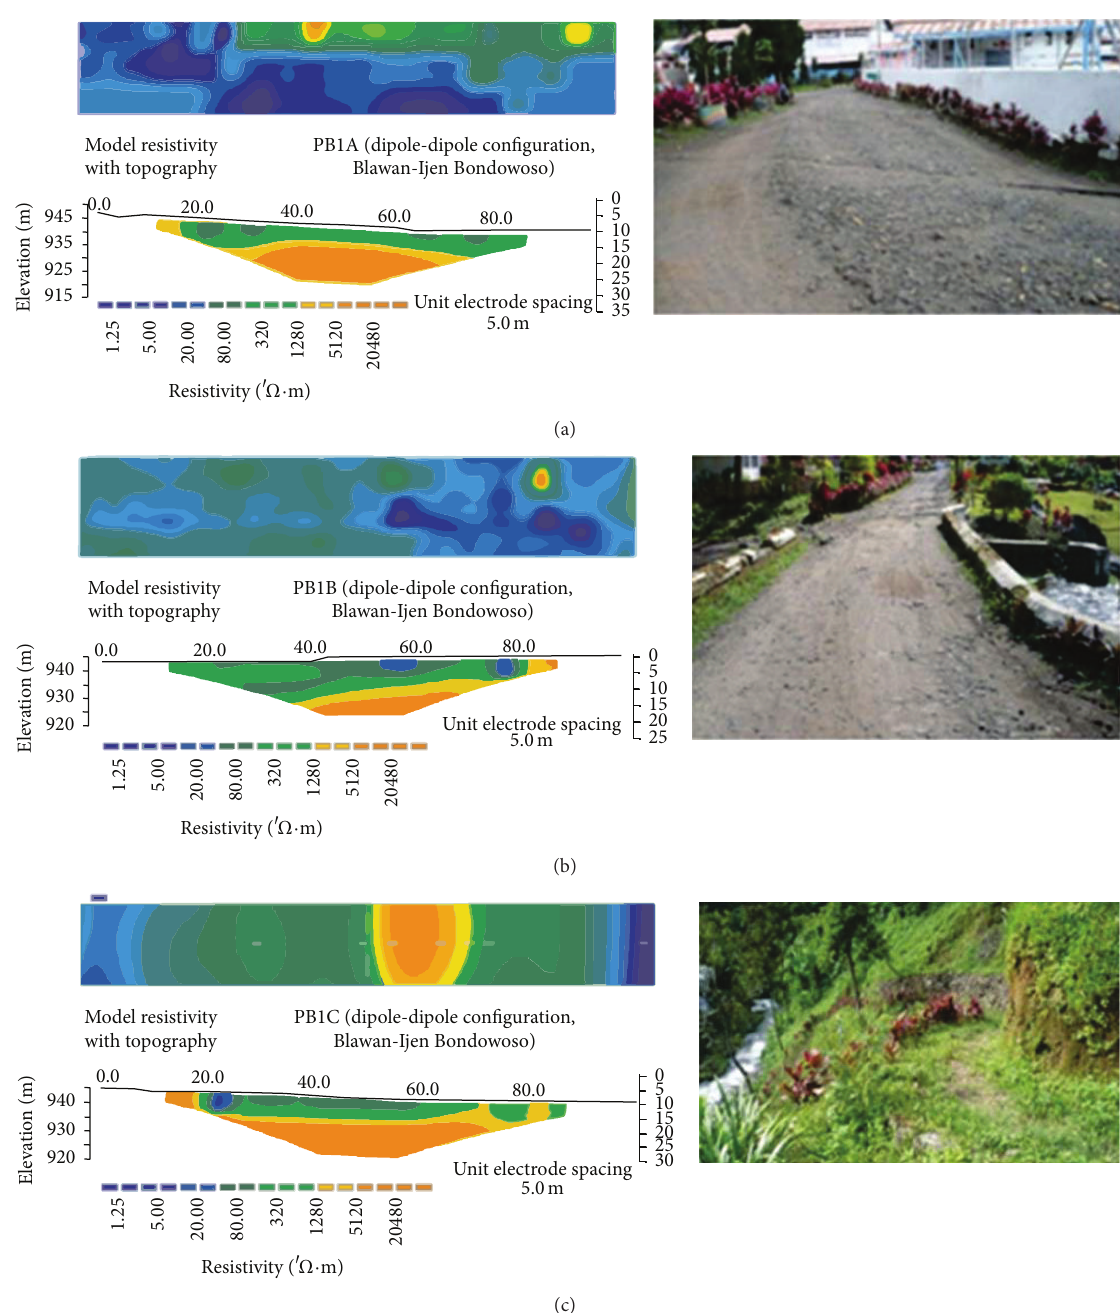
Figure 5: 2D Resistivity Mapping and GPR amplitude slice in locations (a) PB1A, (b) PB1B, and (c) PB1C.